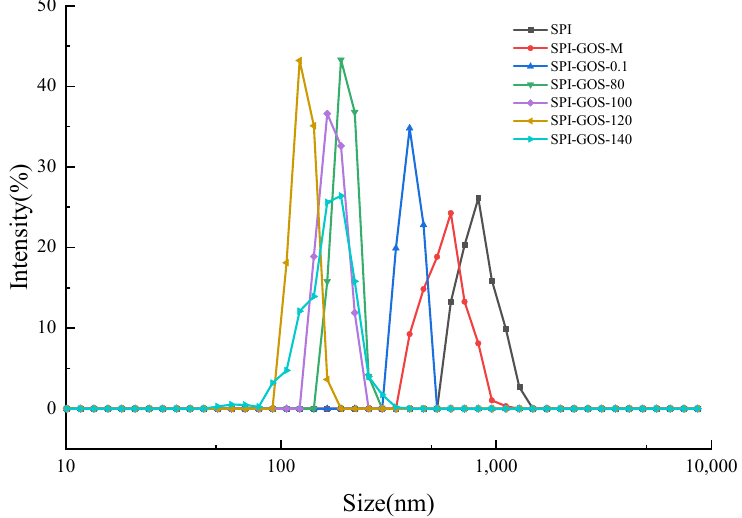
Figure 11. Average particle size of emulsions created with the samples. SPI is the native soy protein isolate; MIX represents the mixture of SPI and GOS; 0.1 MPa represents the traditional wet heating Maillard reaction group; 80 MPa, 100 MPa, 120 MPa, and 140 MPa are the HPH treatment groups.